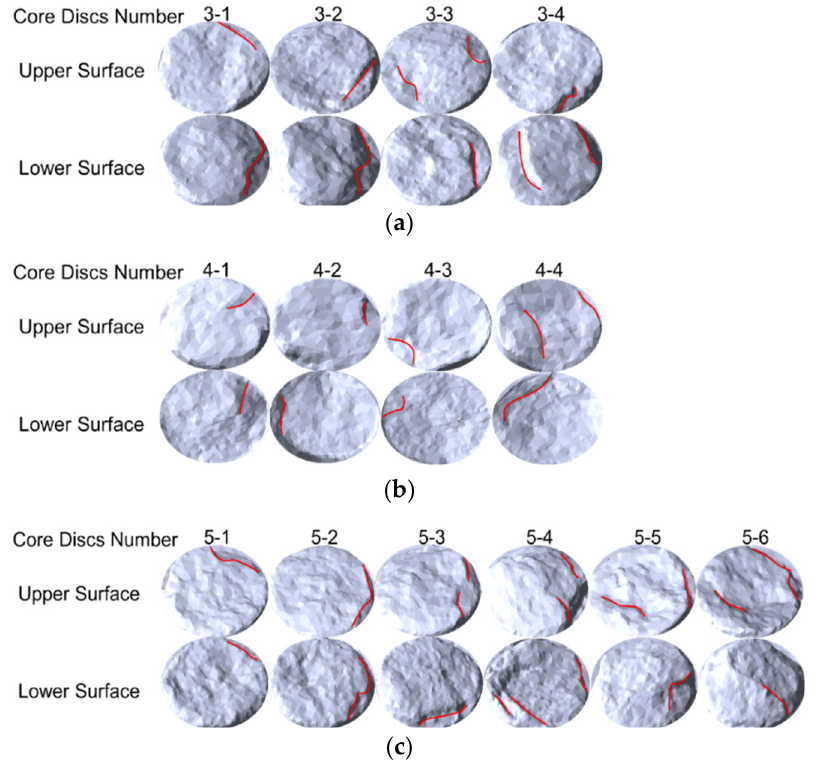
Figure 11. Digital model of core disc surface. ( a ) Test 3; ( b ) Test 4; ( c ) Test 5.